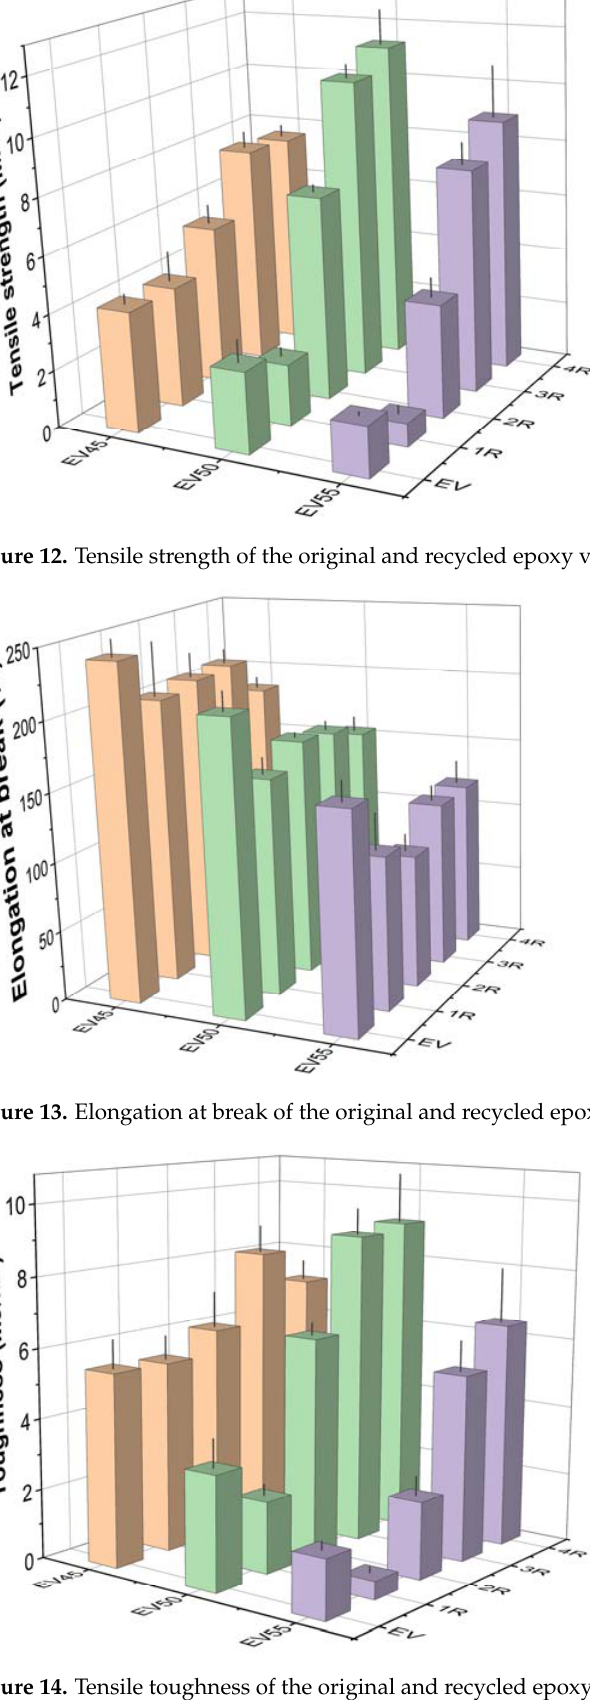
Figure 14. Tensile toughness of the original and recycled epoxy vitrimers.